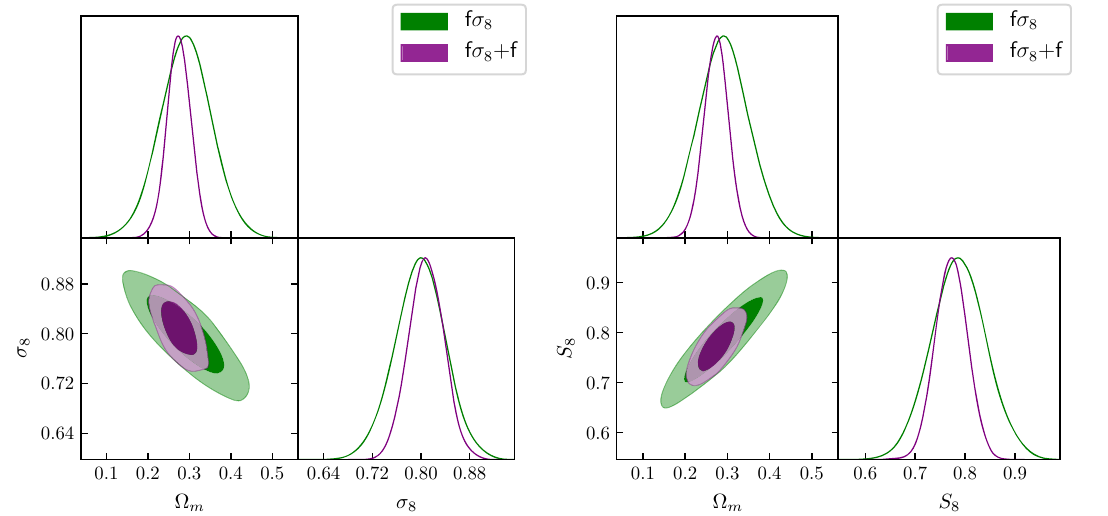
Fig. 5 1D and 2D posterior distributions for [ f σ 8 ] ( z ) and [ f σ 8 ] ( z ) + f ( z ) data at 1 σ and 2 σ CL. Left panel: contour diagram on the plane (cid:6) − σ m 8 . Right panel: contour diagram on the plane